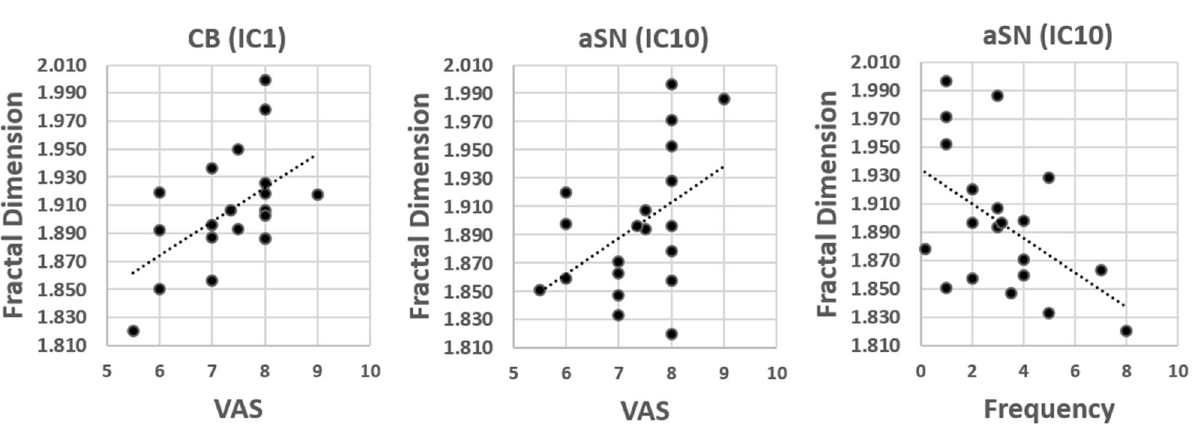
Figure 3. Scatterplots between BOLD IC FD values and clinical variables. Correlation analysis between FD values of IC1 (Cb) and IC10 (aSN) BOLD activity and clinical variables (Frequency and